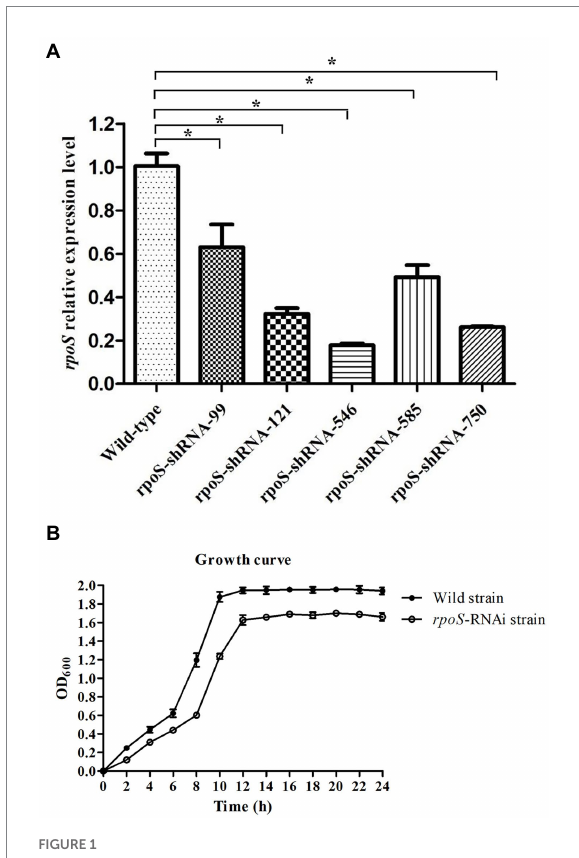
FIGURE 1 Construction of RNAi strains of Enterobacter cloacae . (A) Gene expression levels of rpoS after stable gene silencing, the asterisk indicated significant differences between the RNAi and wild E. cloacae , p < 0.05. (B) Growth curve of wild-type and rpoS -RNAi